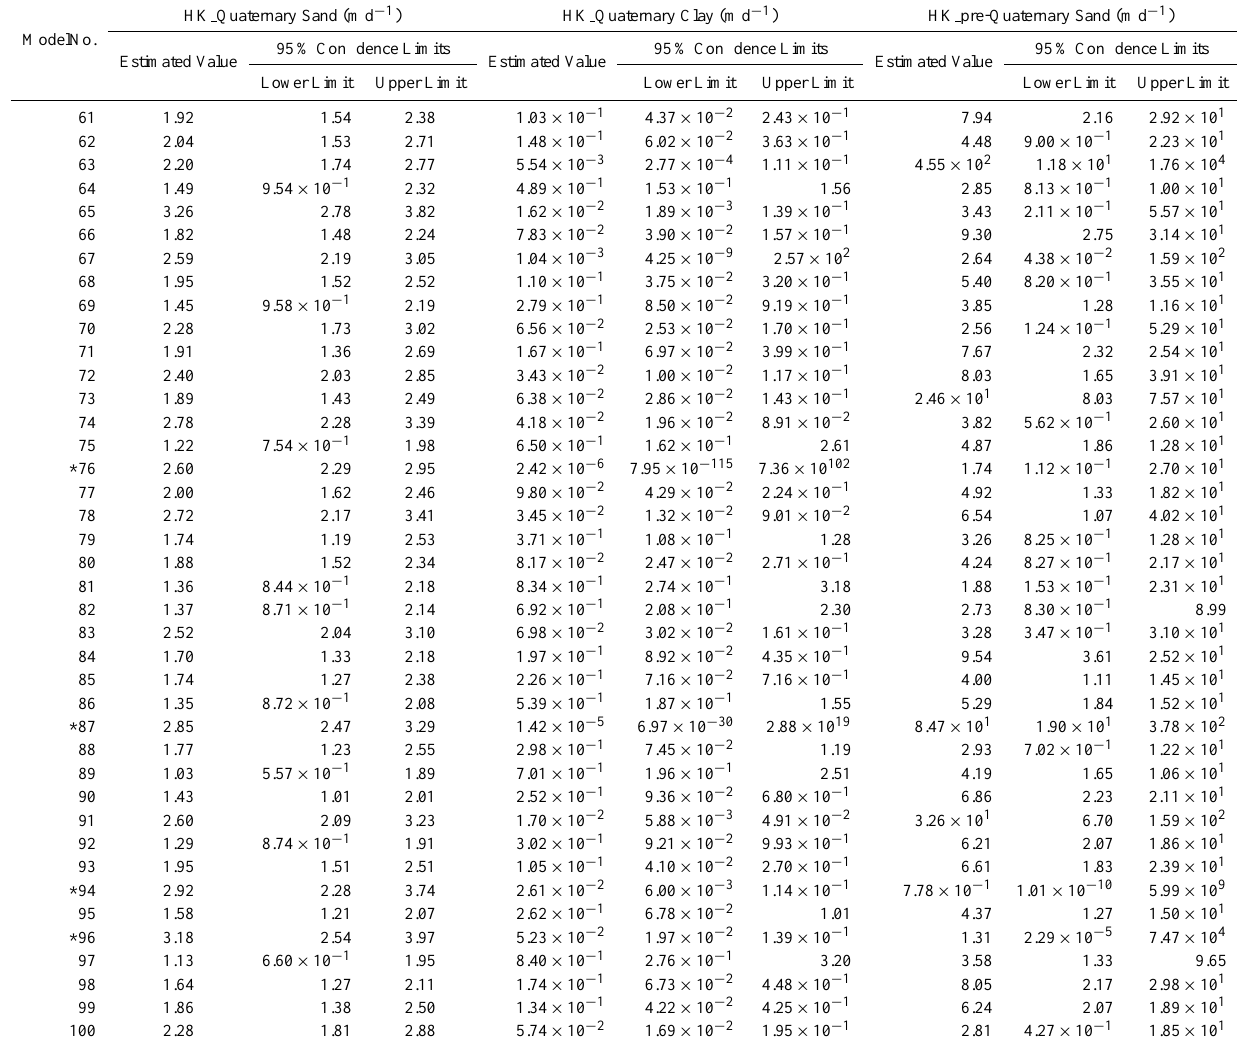
Table A1. Estimated hydraulic conductivity and confidence limits from PEST.